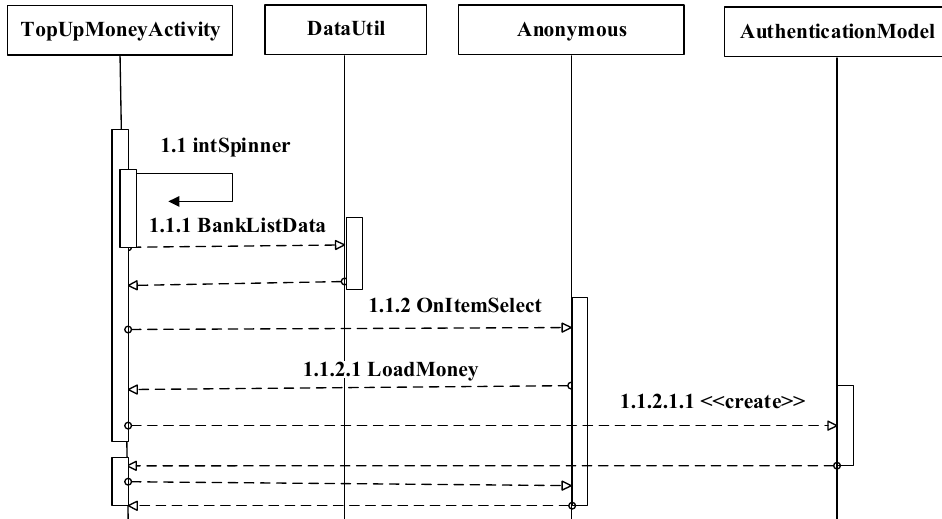
Figure 9. Top-up money activity of proposed method. Step 1.1: The InitSpinner will start and return a message to the TopUpMoneyActivity. Step 1.1.1: The TopUpMoneyActivity sends request BankListData to the DataUtil and waits for the response. Step 1.1.2: The TopUpMoneyActivity sends request